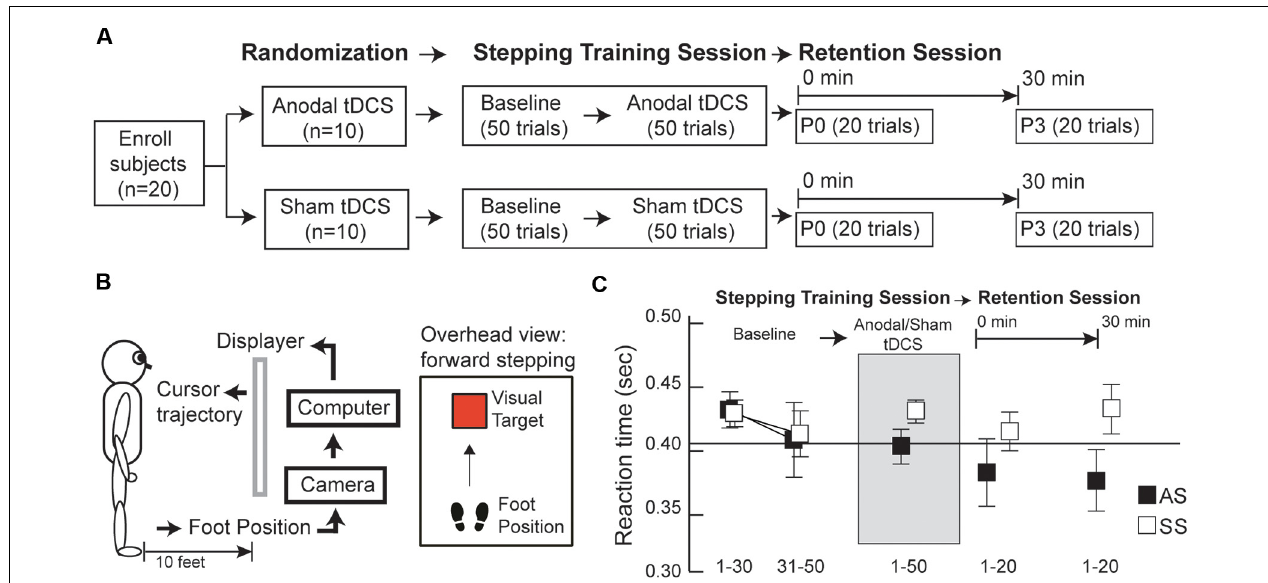
FIGURE 1 | (A) Experimental design, (B) visuomotor step task setup, (C) average reaction times (RTs) for anodal and sham transcranial direct current stimulation (tDCS) groups (AS and SS, respectively) before, during, and after tDCS. (A) Subjects were randomly assigned to one of two tDCS groups (anodal or sham tDCS) and underwent two sessions: a training session followed by a retention session. During the training session, subjects first completed 50 stepping trials before tDCS (baseline, BS) and additional 50 stepping trials, combined with either anodal or sham tDCS. In the retention session, 20 stepping trials were conducted at two time-points post-tDCS: 0 and 30 min after tDCS (P0 and P3, respectively). (B) Subjects learned to move the foot cursor to a visual target using real-time visual feedback. (C) Group average RTs were calculated before, during, and after tDCS. Before tDCS, the average of the last 20 trials at BS was comparable between